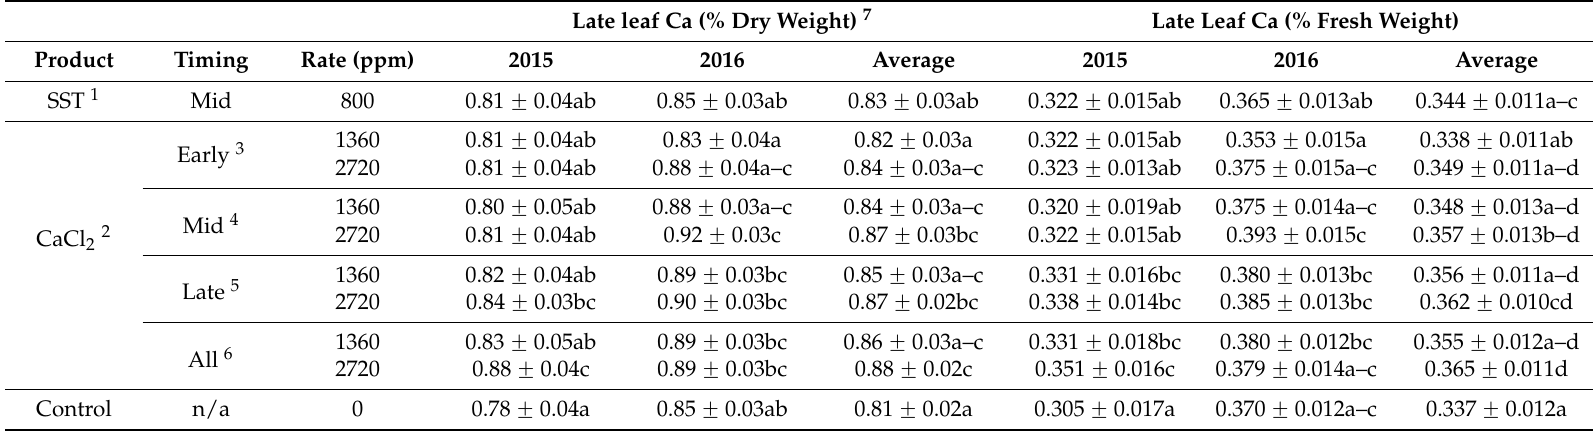
Table 6. Mean ˘ SE late leaf sample concentration on a dry and fresh weight basis in ‘Draper’ highbush blueberry in response to foliar Ca products, application timings and rates across three sites in the Fraser Valley, British Columbia, Canada in 2015 and